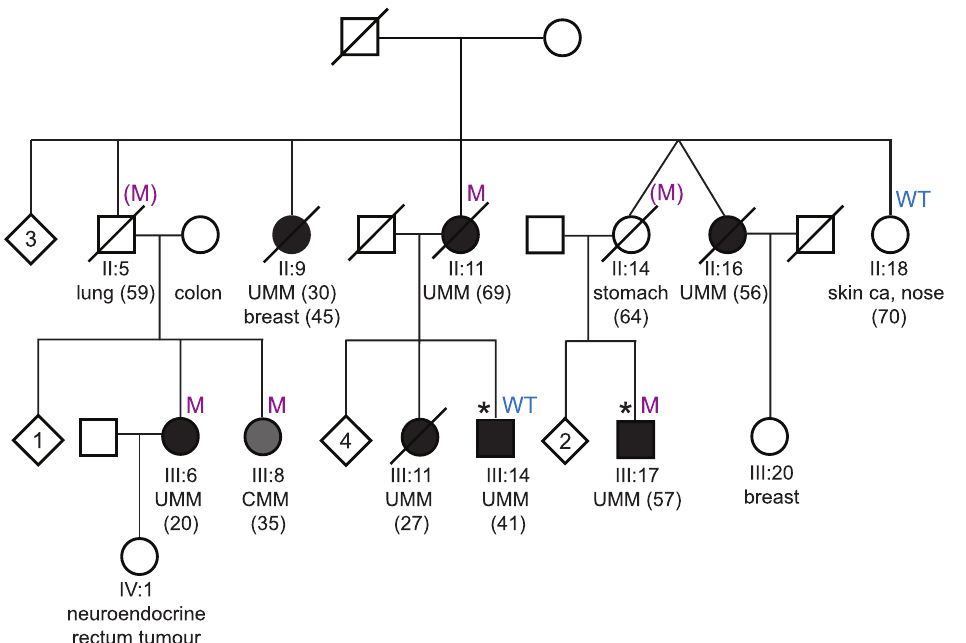
Figure 1. Co-segregation analysis of a BAP1 splice mutation in a Danish family. In the pedigree individuals that have uveal melanoma (UMM) are represented by black circles (female) or boxes (male) and individuals with cutaneous melanoma (CMM) are indicated by grey circles or boxes. The age of diagnosis of each melanoma is indicated in brackets. A line through a symbol indicates that the person is now deceased. If a person carries the BAP1 splice mutation it is indicated by an ‘M’ and if they are wild type for this variant it is indicated with a ‘WT’. Where the mutation status is indicated in brackets, the person is a presumed obligate carrier, ‘(M)’. Other cancer types are also indicated in the pedigree with the age of diagnosis in brackets. Asterisks indicate the two individuals that were exome sequenced. Unaffected siblings are represented by diamonds, with the number in the centre indicating the number of people.